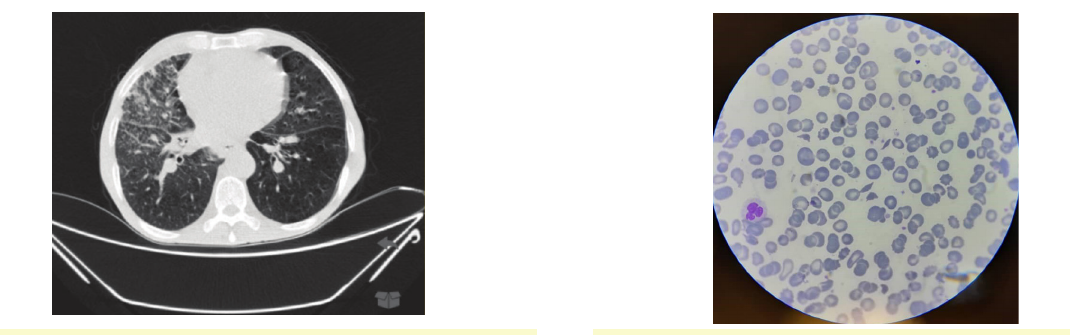
Figure 2. Chest computed tomography (CT); diffuse hyper-aeration of both lungs with interstitial infiltrations in the right middle, right upper, and right lower lobes as well as inter-lobar fissural nodular lesions.